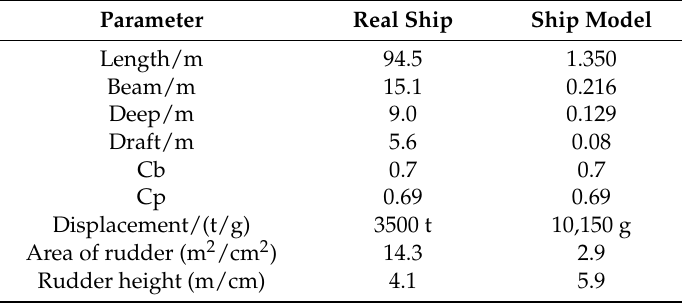
Figure 7. Ship model. Table 1. Primary parameters of the ship.